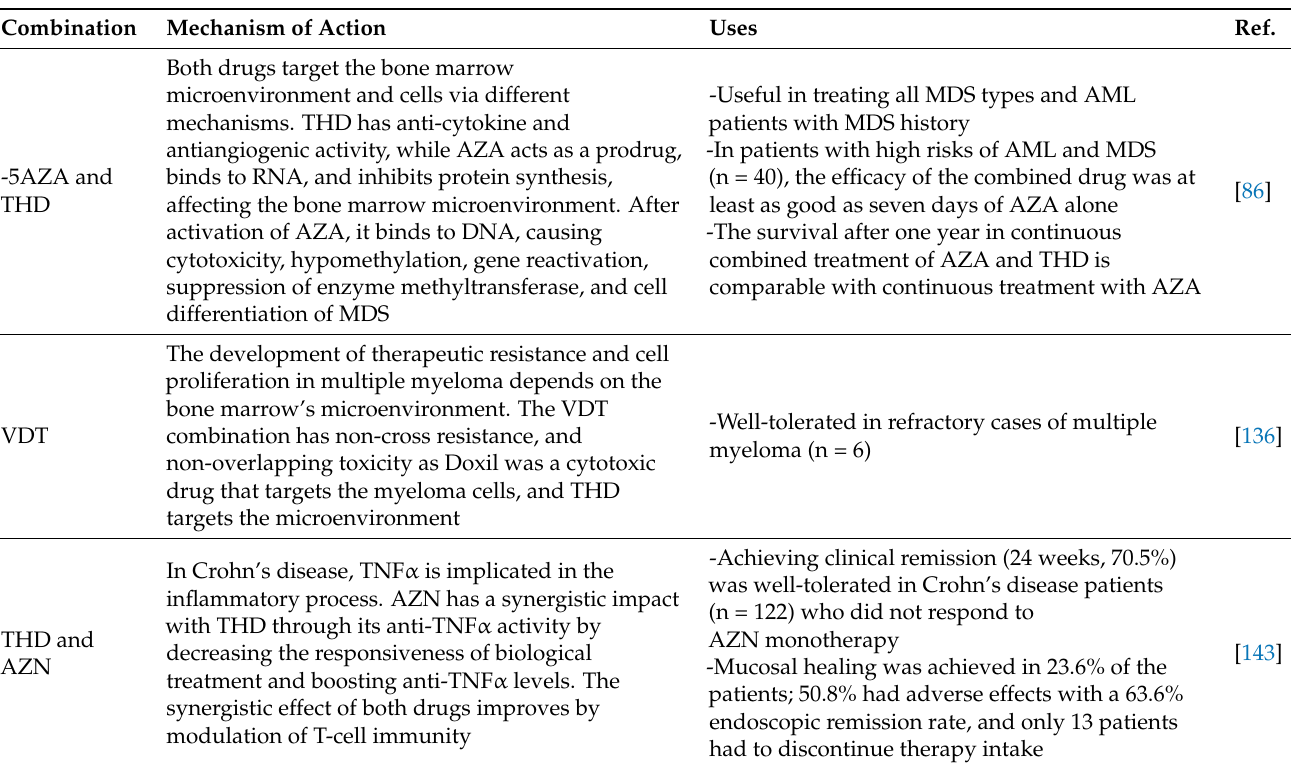
Table 2. The combined uses of THD with multiple